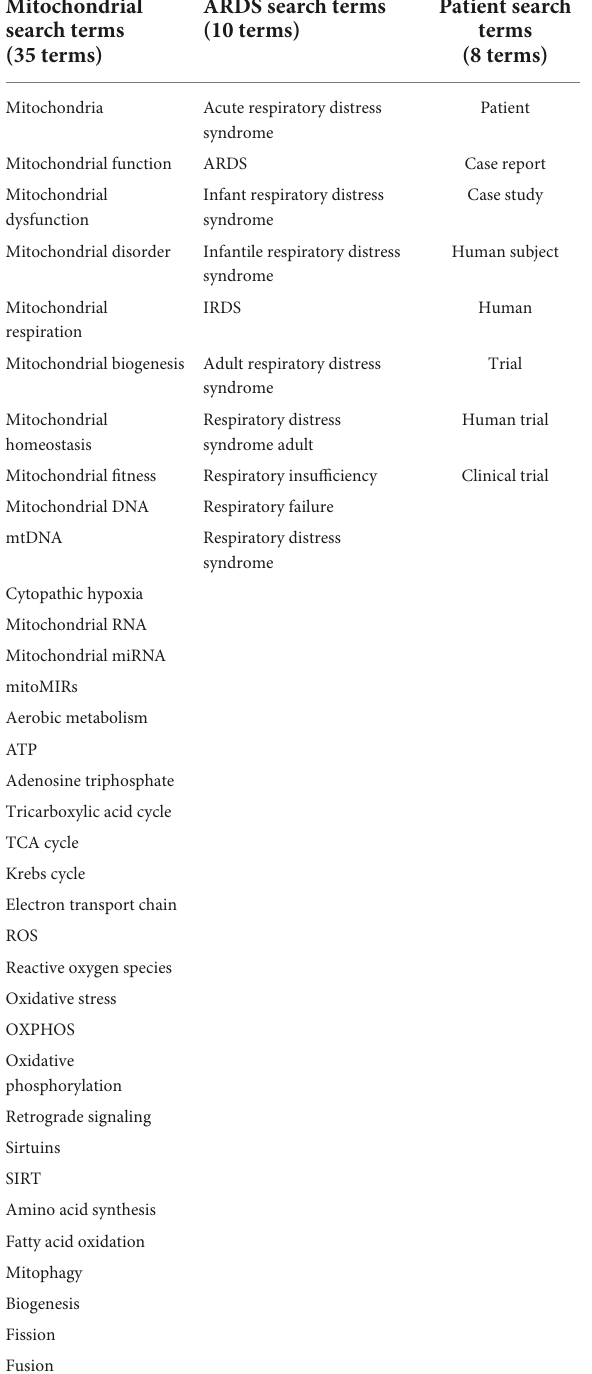
TABLE 1 Title and abstract article screening